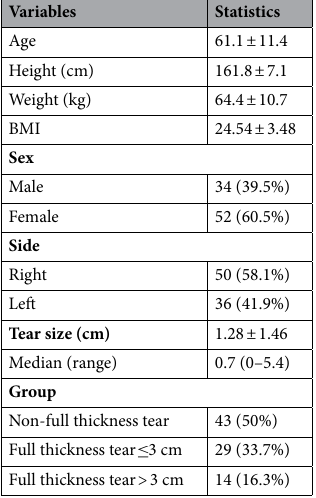
Table 1. Summary of the demographic data of patients.